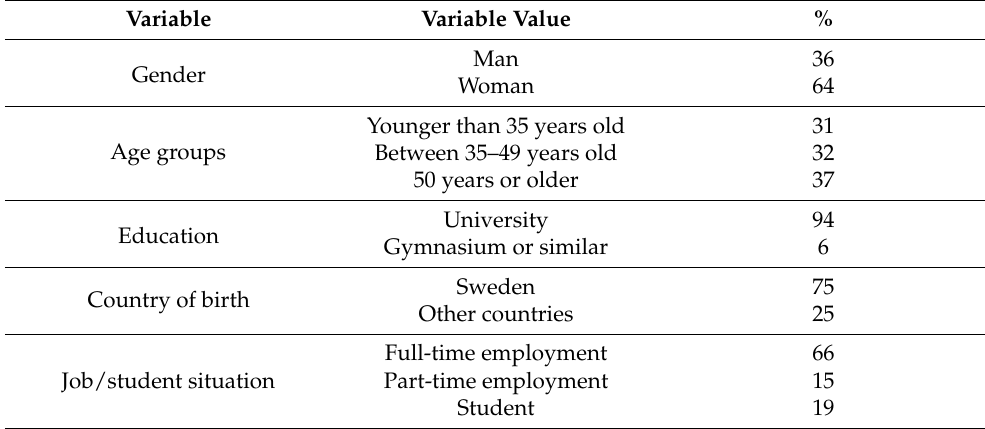
Table 1. Sample characteristics ( n = 278), by